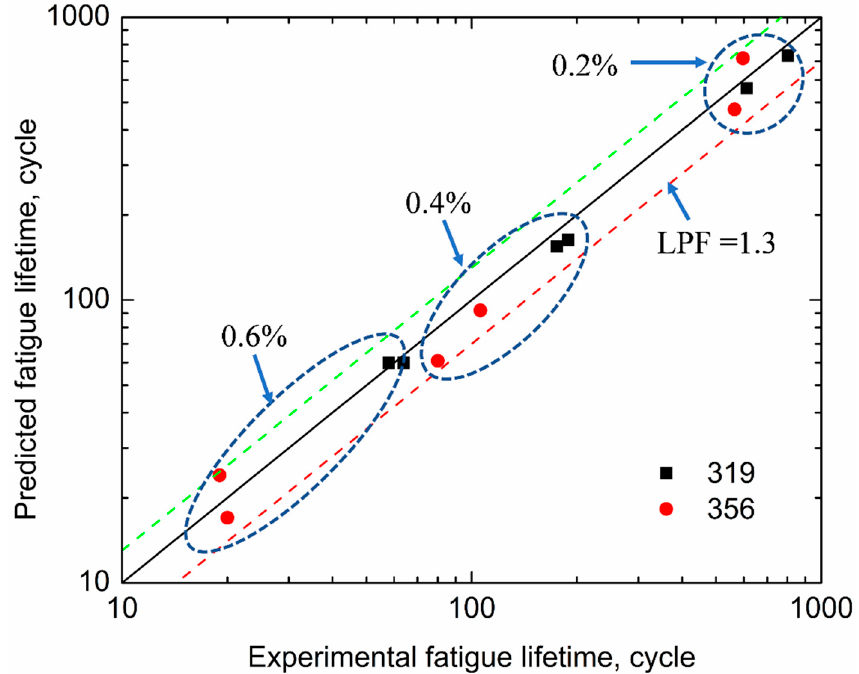
Figure 11. Comparison of predicted and experimental fatigue lifetimes for 356 and 319 alloys.